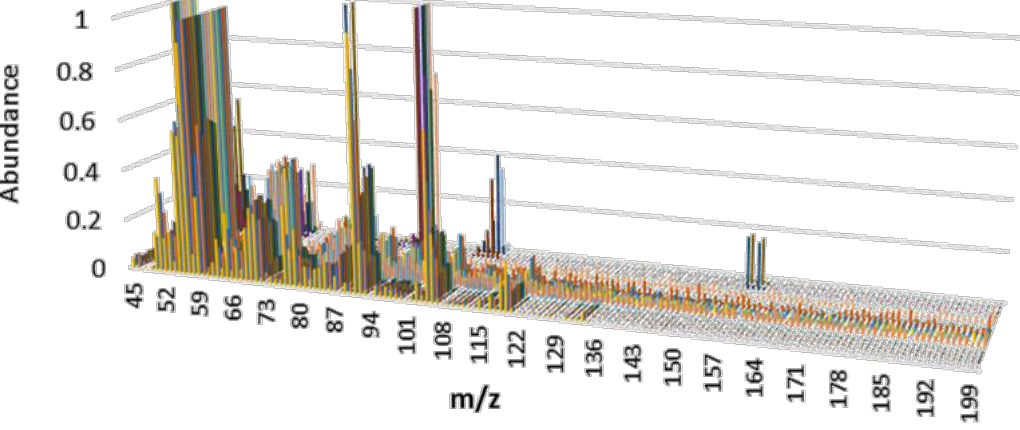
Figure 1. Mass spectra for all samples, including supported petroleum-derived product (PDP) samples and materials without PDPs ( n = 39) analyzed by an electronic nose system.